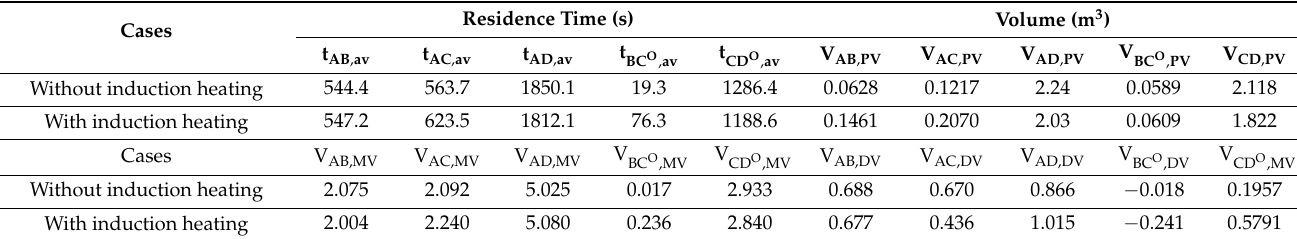
Table 9. Analysis results for the RTD curve with the combined model in the tundish with and without channel induc- tion